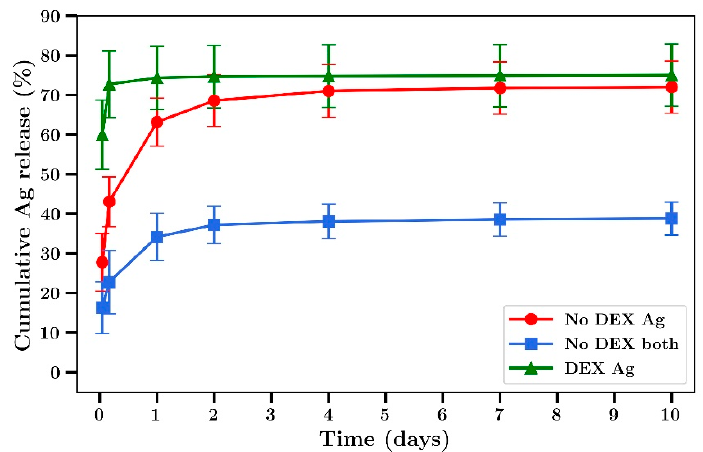
Figure 4. Time course of Ag release from Palacos bone cement films. Cement loaded with or without dextran T70 (18% w/w ) and silver nitrate. (Silver loaded at 0.8% and gentamicin at 0.8% w/w ). No DEX both refers to cement with gentamicin and Ag and no dextran ( n = 4).